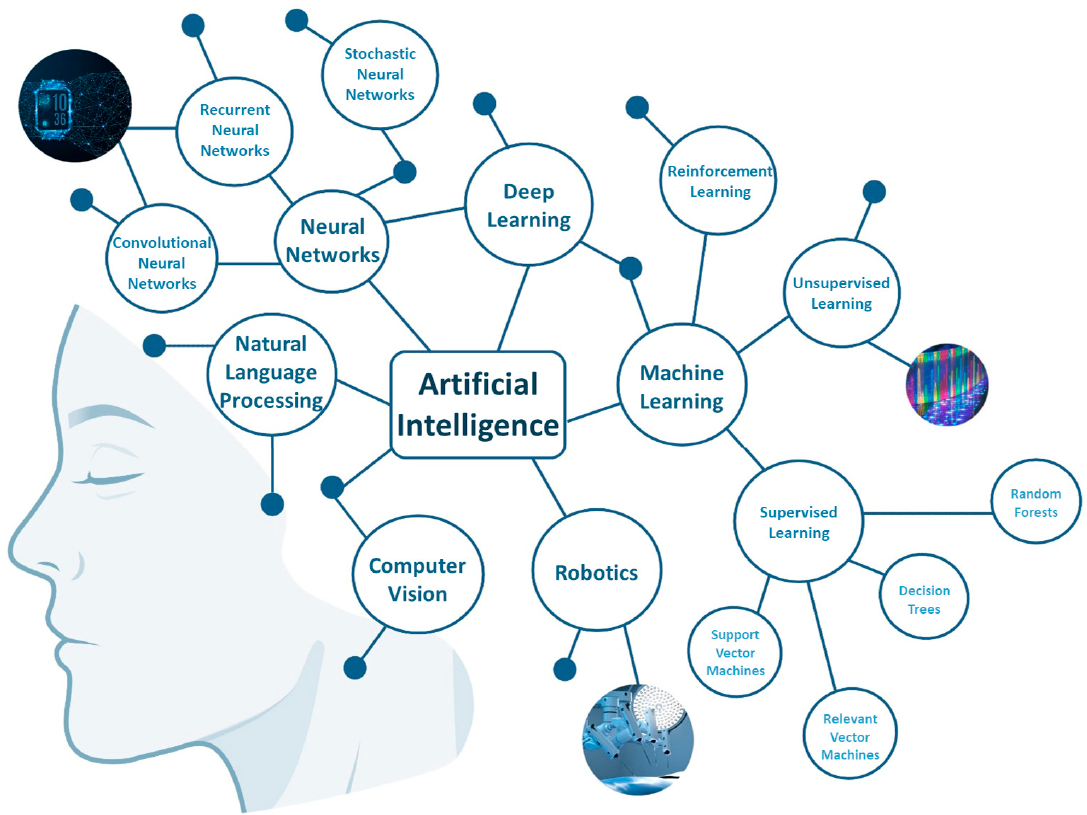
Figure 1. The six main fields of AI. ML includes three basic sub-subsets depending on the type of input and output data. NNs are divided into two distinct groups: CNN and RNN. DL combines the ML and ANNs methods. NLP, CV, and Robotics are additional types of AI.